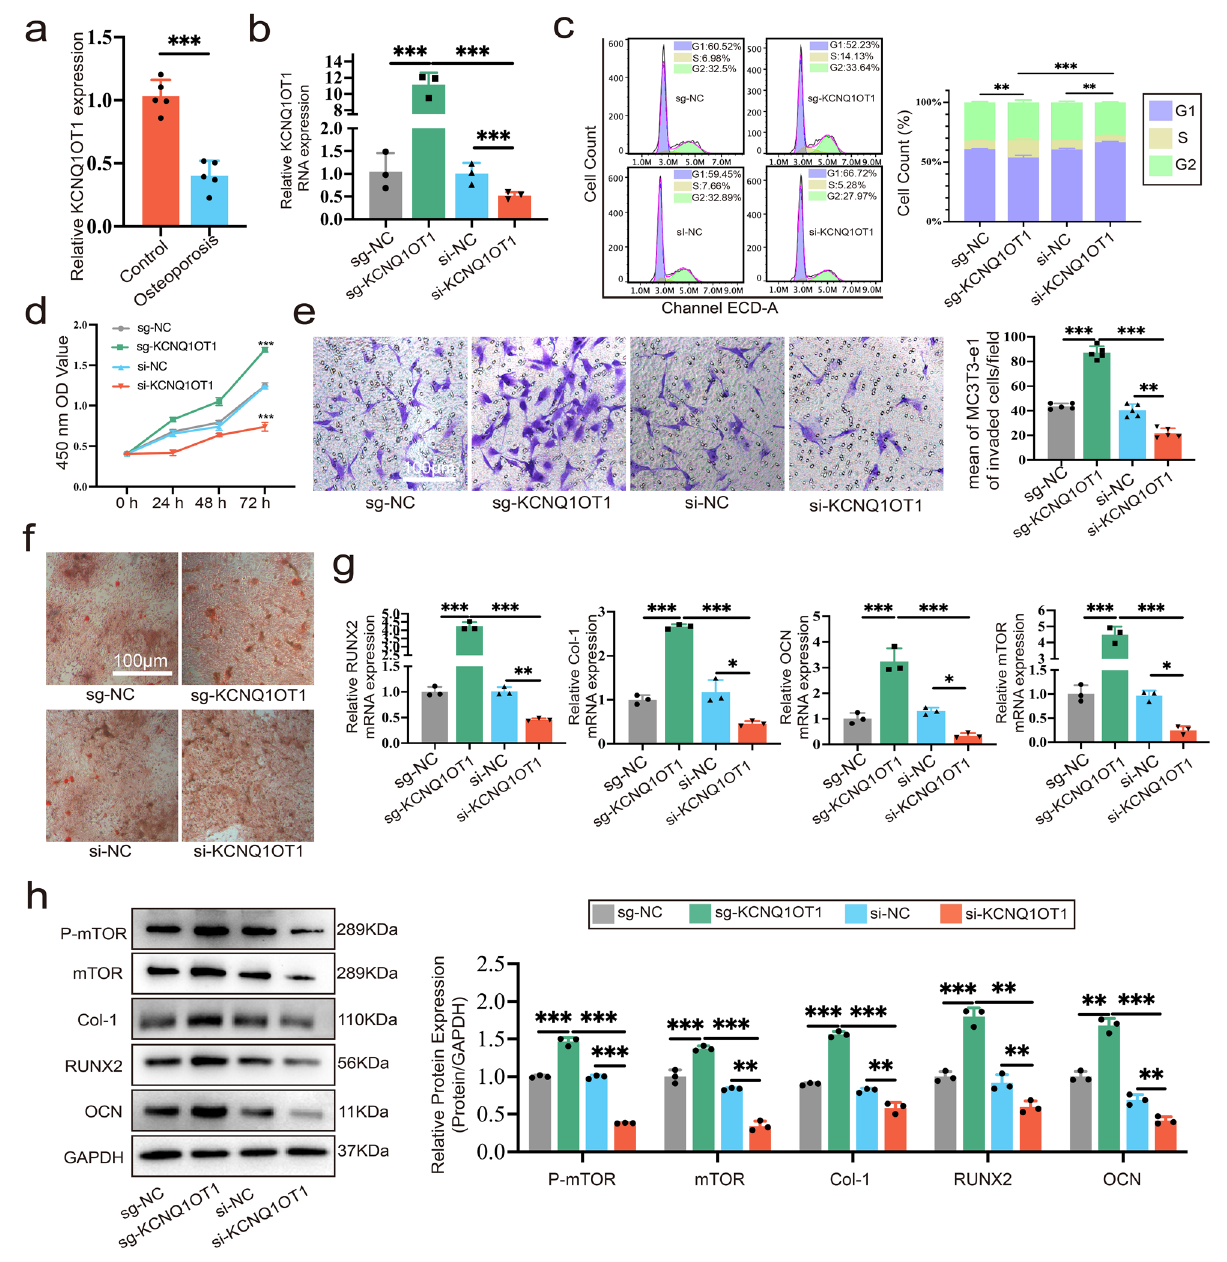
Figure 1. KCNQ1OT1 enhances the proliferation, migration and osteogenic differentiation of MC3T3-E1 cells. MC3T3-E1 cells were transfected with sg-KCNQ1OT1, sg-NC, si-KCNQ1OT1, si-NC, respectively. ( a ) Relative KCNQ1OT1 expression in bone tissues of patients with osteoporosis and controls without osteoporosis by qRT- PCR (N = 5). ( b ) RNA expression of KCNQ1OT1 were examined by qRT-PCR analysis to detect the transfection efficiency. ( c ) MC3T3-E1 cell cycle analysis after PI staining. ( d ) Through the CCK-8 assay, the impact of KCNQ1OT1 on the ability of MC3T3-E1 cells to proliferate was evaluated. ( e ) MC3T3-E1 cells migration ability was tested using a transwell migration experiment to show the impacts of KCNQ1OT1. ( f ) Representative images of MC3T3-E1 cells stained with alizarin red after transfection and 14 days of osteogenic induction. ( g ) RNA expression of RUNX2, Col-1, OCN and mTOR were examined by qRT-PCR analysis. ( h ) Protein expression levels of pmTOR, mTOR, Col-1, RUNX2 and OCN were analyzed by Western blot after transfection and osteogenic differentiation for seven days. Uncropped Western blot images are shown in Supplementary Fig. 5. *P < 0.05, **P < 0.01, ***P <